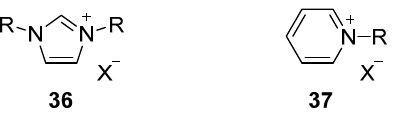
Figure 8. Generic structure of the two most investigated classes of ILCs: imidazolium ( 36 ) and pyridinium ( 37 ) salts. The imidazolium salts have the advantage that they allow easy asymmetric substitution at the heteroatoms of the ring.